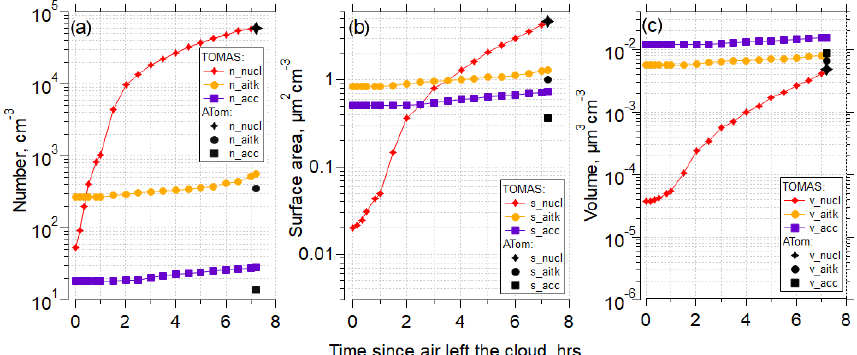
Figure 7. (a) TOMAS box model simulation of the case (case identifier: sd486) shown in Fig. 6 for the lowest (best) NME for the RIC scheme, showing number concentration of the nucleation (3–12nm), Aitken (12–60nm) and accumulation (60–500nm) modes as a function of time since the air parcel exited the cloud to the time of measurement by the aircraft. Black symbols indicate values at the point of measurement. The measured Aitken and accumulation mode values from the observations were used as approximate initial conditions for the model simulation and are shown at time t = fin. (b) As in (a) but for surface area concentrations. (c) As in (a) but for volume concentrations. Conditions for the simulations were diurnally varying OH concentrations with solar zenith angle. Initial SO 2 = 1 . 3pptv, and initial organics = 5.5pptv.